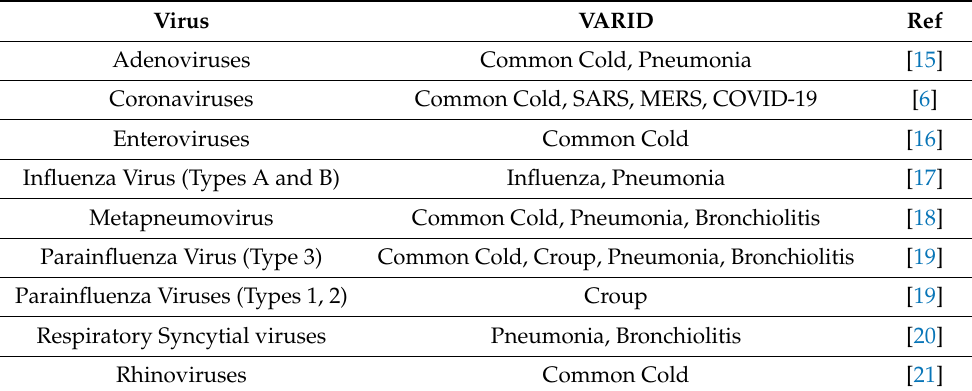
Table 1. Common viral respiratory infections and the associated respiratory infection disease. Virus VARID Ref